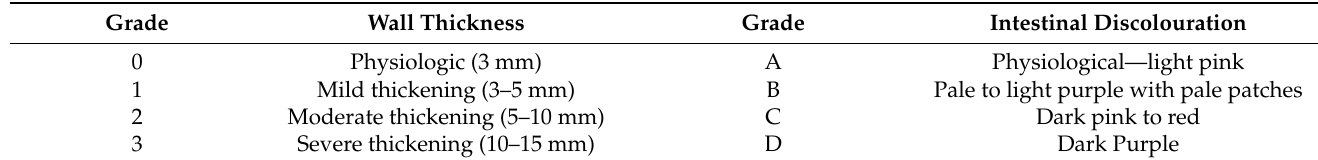
Figure 1. Timeline of the experiment and associated sampling. P = pre-ischaemia; I0 = immediately following induction of ischaemia; I1 = after 60 min ischaemia; I2 = after 120 min of ischaemia; R0 = immediately following reperfusion; R1 = after 60 min of reperfusion; R2 = after 120 min of reperfusion; RC = remote control segment after reperfusion. Table 1. Semiquantitative scores for the clinical evaluation of the intestine.